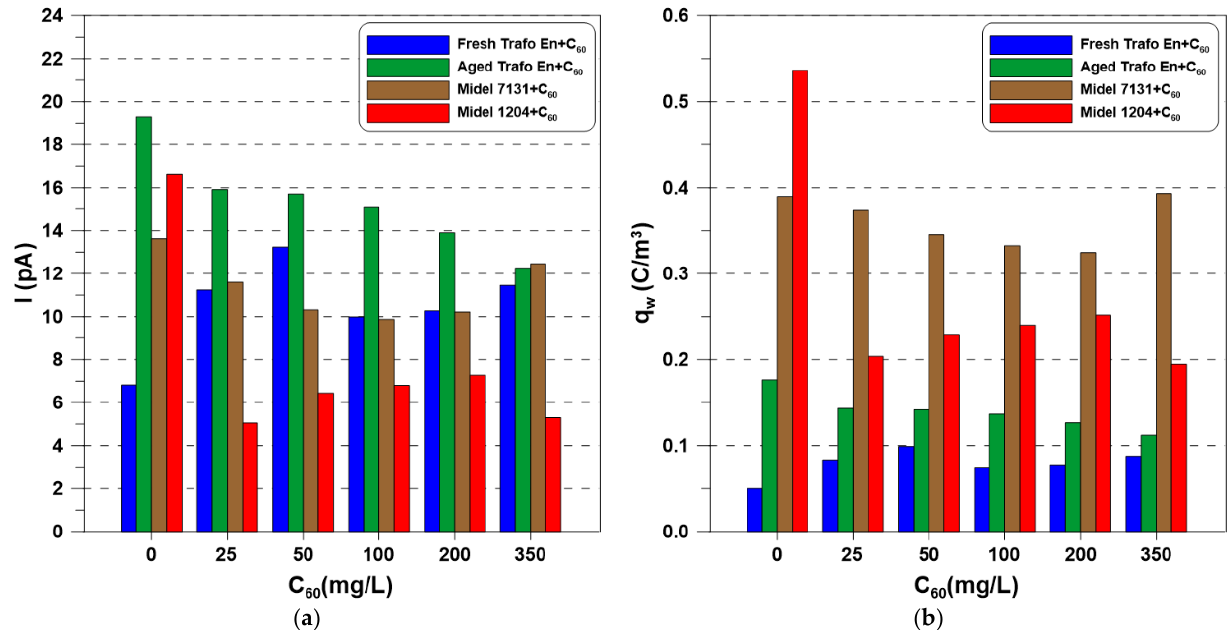
Figure 7. ( a ) Electrification current and ( b ) volume charge density q w of insulating liquids versus concentration of C 60 ( v = 0.34 m/s, T = 20 °C).